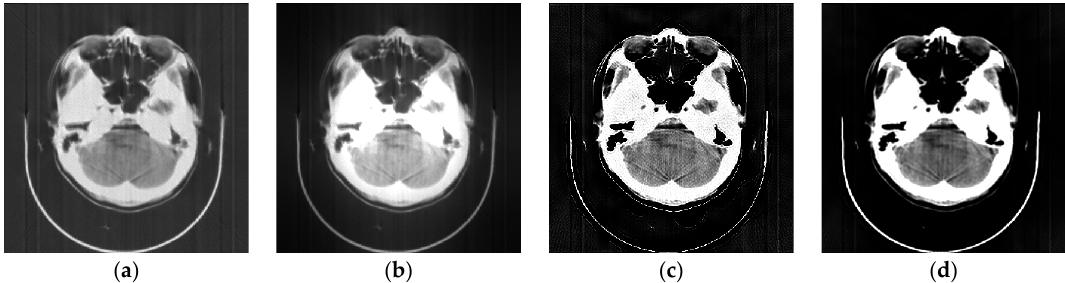
Figure 6. Comparison of the reconstructed images for the selected slice of head phantom: ( a ) Image reconstructed by OSEM; ( b ) image reconstructed by OSEM-BD; ( c ) image reconstructed by RL-OSEM; ( d ) image reconstructed by the proposed method.